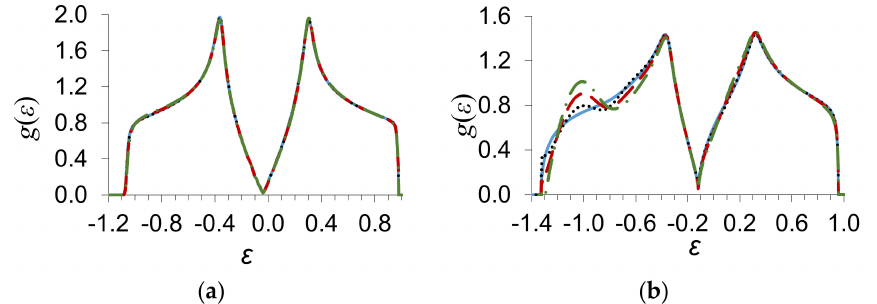
Figure 1. Dependence of the density of electron states g ( ε ) on the energy ε at the concentration of a substitutional impurity y = 0.2, for di ff erent values of the parameter of binary interatomic correlations = ε BB , η = 0, and values of the scattering potential: ( a ) δ / w = − 0.2, on the first coordinate sphere ε BB lj 0 i ( b ) δ / w = − 0.6. The density of electron states calculated in the approximation of coherent potential is shown by a continuous curve with regard to the processes of scattering on the pairs of atoms in the limits of the first coordinate sphere; the dotted curve corresponds to ε BB = 0 , the dashed line to ε BB = − 0.05 , and the dash-dotted curve to ε BB = − 0.1